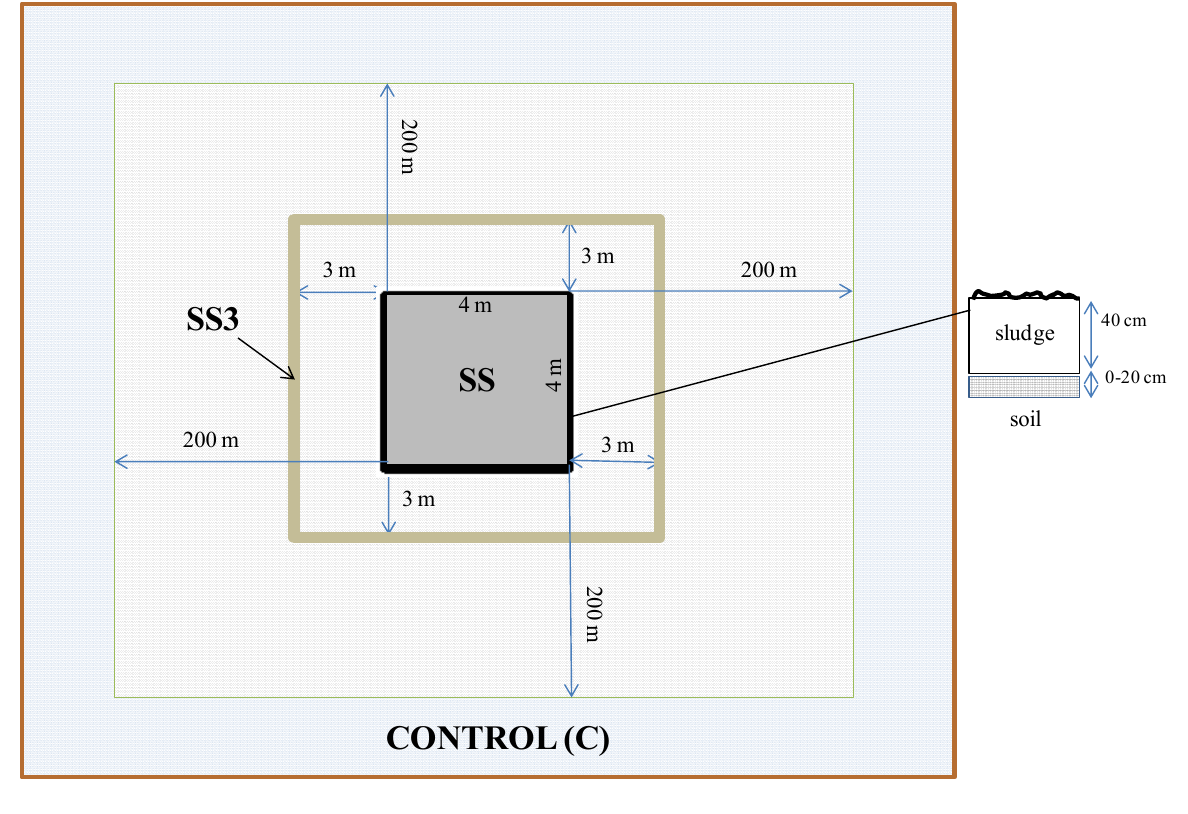
Figure 1. The research site near the Nałęczów sewage sludge